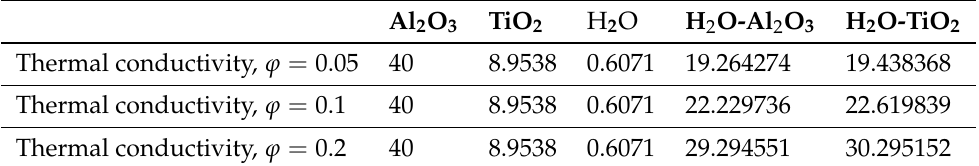
Table 6. Comparative thermal-conductivities of water, nano-particles, and nanofluids at T = 390 K.